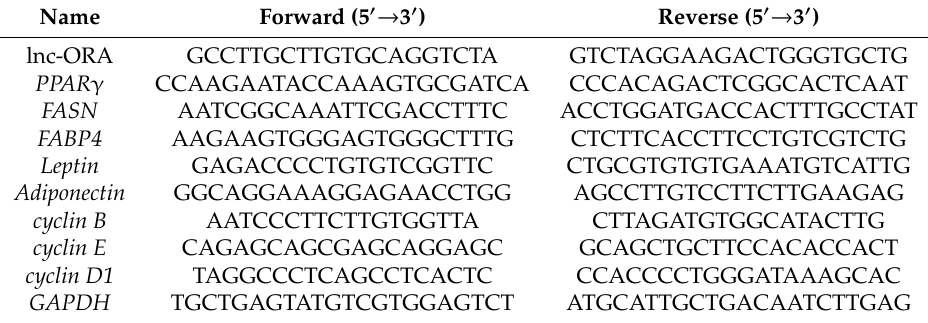
Table 1. Primers used for real-time quantitative PCR